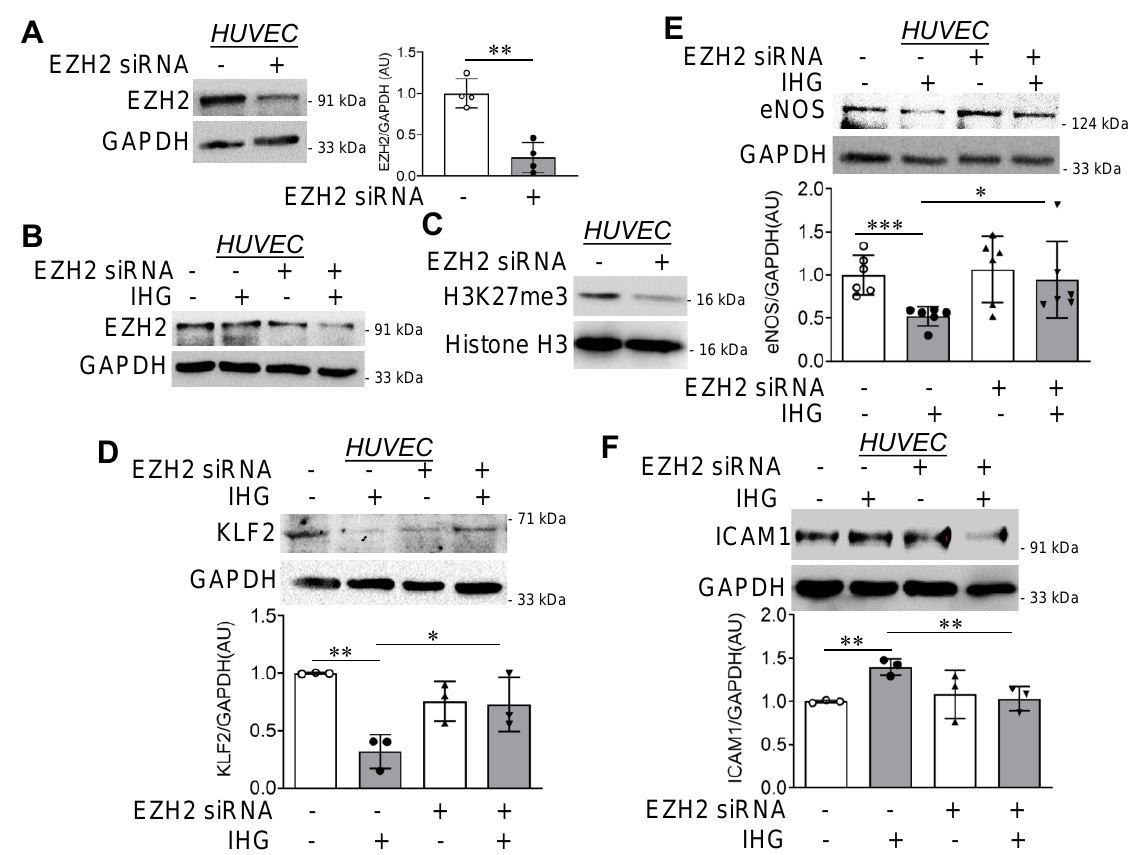
Figure 5. EZH2 knockdown in HUVEC reduces H3K27me3 and reverses intermittent high glucose-driven endothelial inflammation. ( A – E ) Immunoblotting of EZH2 in normal glucose (5.5 mM)-treated HUVEC (( A ), n = 4), EZH2 in both normal glucose (5.5 mM) and intermittent high glucose-treated HUVEC (( B ), n = 3), H3K27me3 (( C ), n = 3) and quantification of KLF2 (( D ), n = 3), eNOS (( E ), n = 6), and ICAM1 (( F ), n = 3) in HUVEC cells transiently transfected with scrambled or EZH2 siRNA, followed by challenging with intermittent high glucose. Cells continuously exposed to normal glucose (5.5 mM) were considered as the non-intermittent high glucose treatment condition. All analyzed data were normalized to the control treatment condition. Values represent the mean ± SD. * p < 0.05, ** p < 0.01, and *** p < 0.001 by unpaired t test.